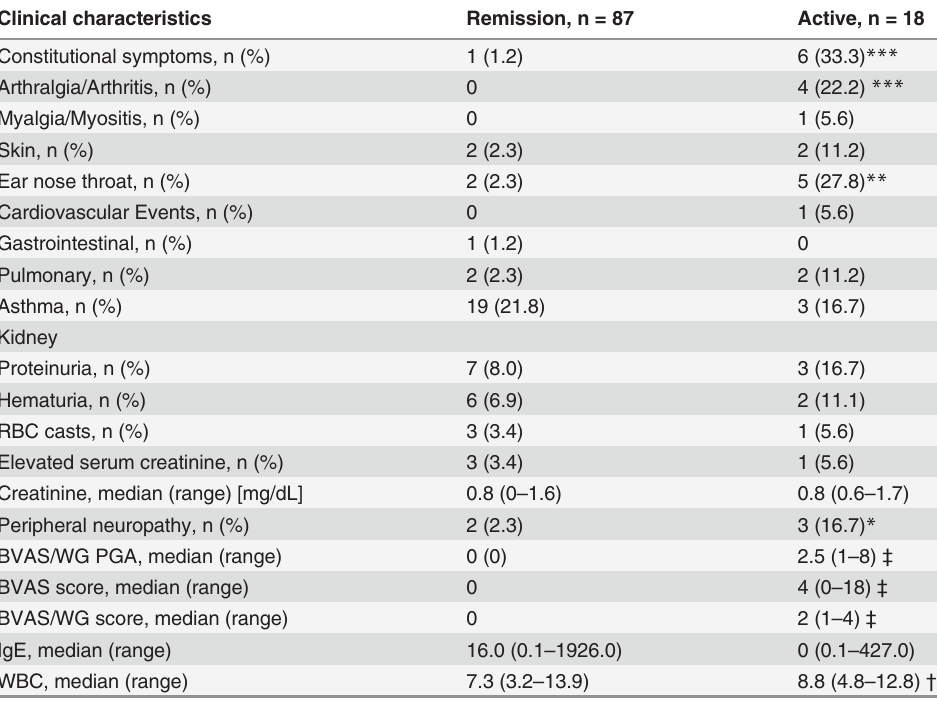
Table 1. Clinical manifestations of study patients with EGPA. Clinical